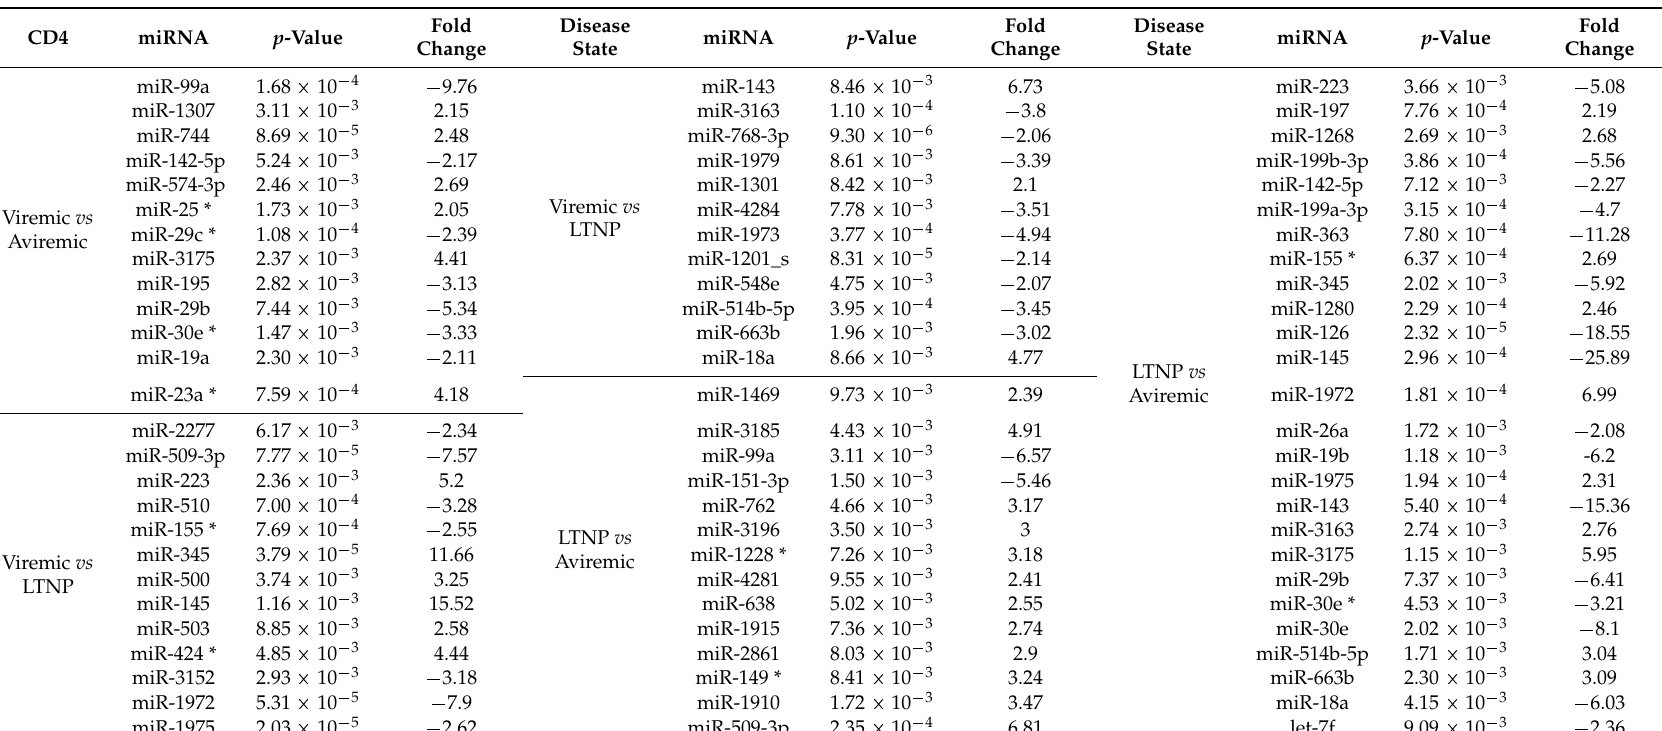
Table A3. Differentially expressed miRNAs when disease classes of CD4 cells are